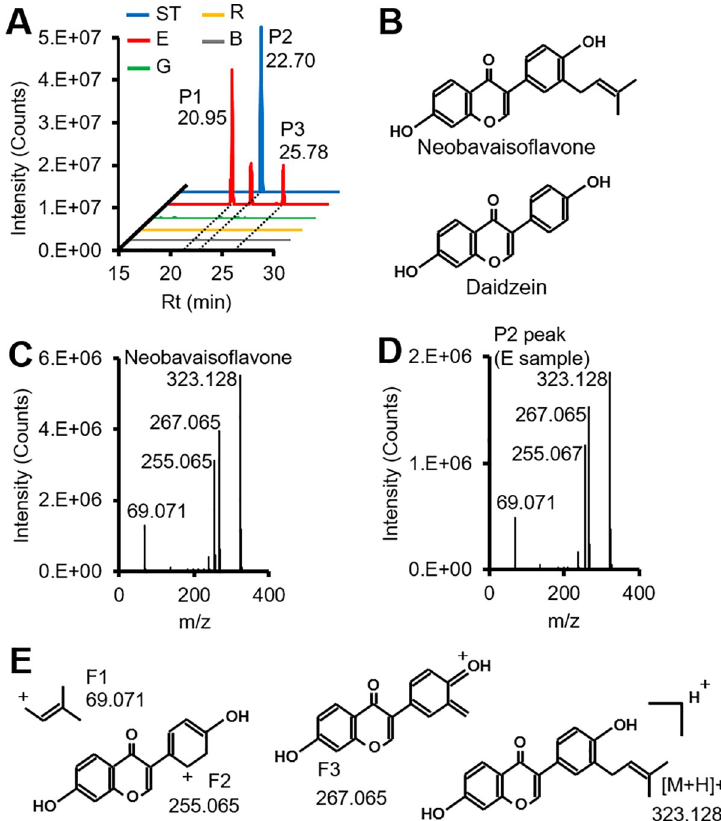
Fig 5. Identification of neobavaisoflavone in A . oryzae -elicited germinated soybean. (A) Extracted ion chromatogram of m/z = 323.1278. ST: standard (neobavaisoflavone, 100 pg); R: raw seed (soybean); G: germination (germinated soybean); E: elicited germinated soybean; B: blank. (B) Structural formulae of neobavaisoflavone and daidzein. MS 2 spectra of (C) neobavaisoflavone and (D) P2 peak (E sample). (E) Structural formulas of neobavaisoflavone fragments (F1-3) and H + adduct ion ([M+H] + ).